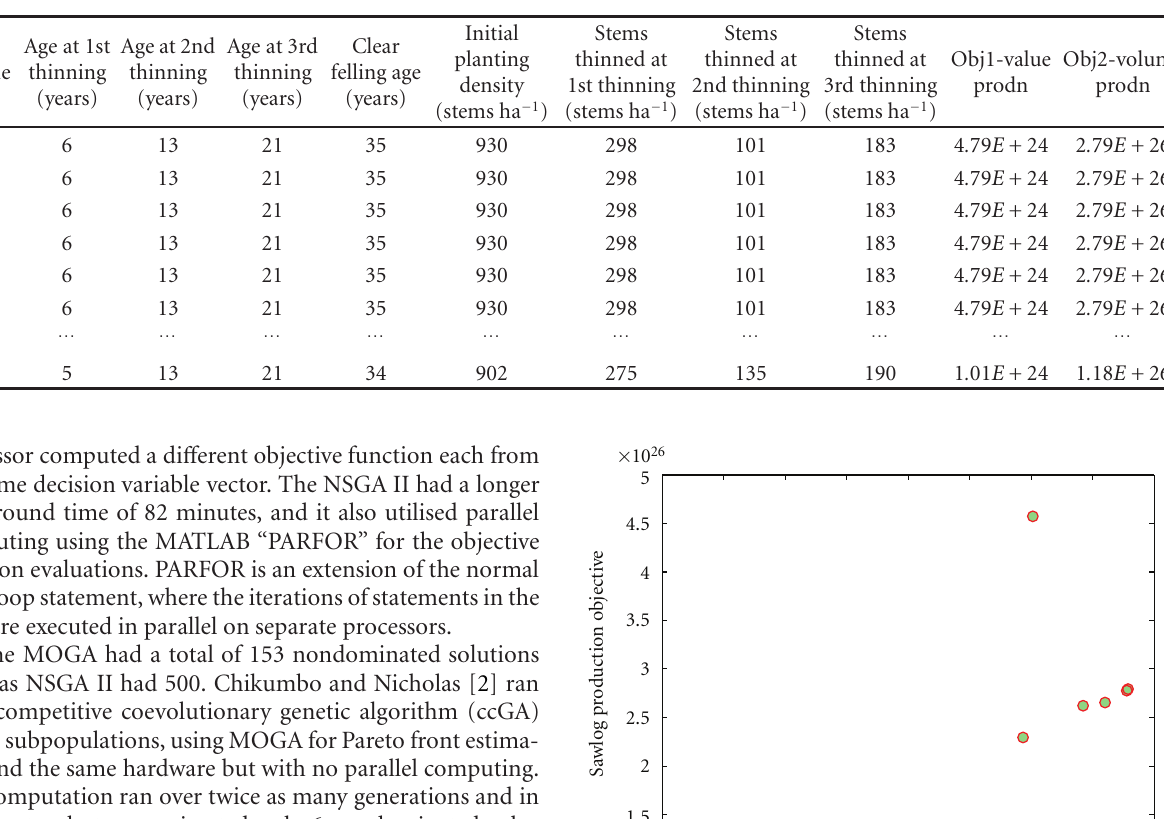
Table 4: Incomplete set of the Pareto front estimated using MOGA.